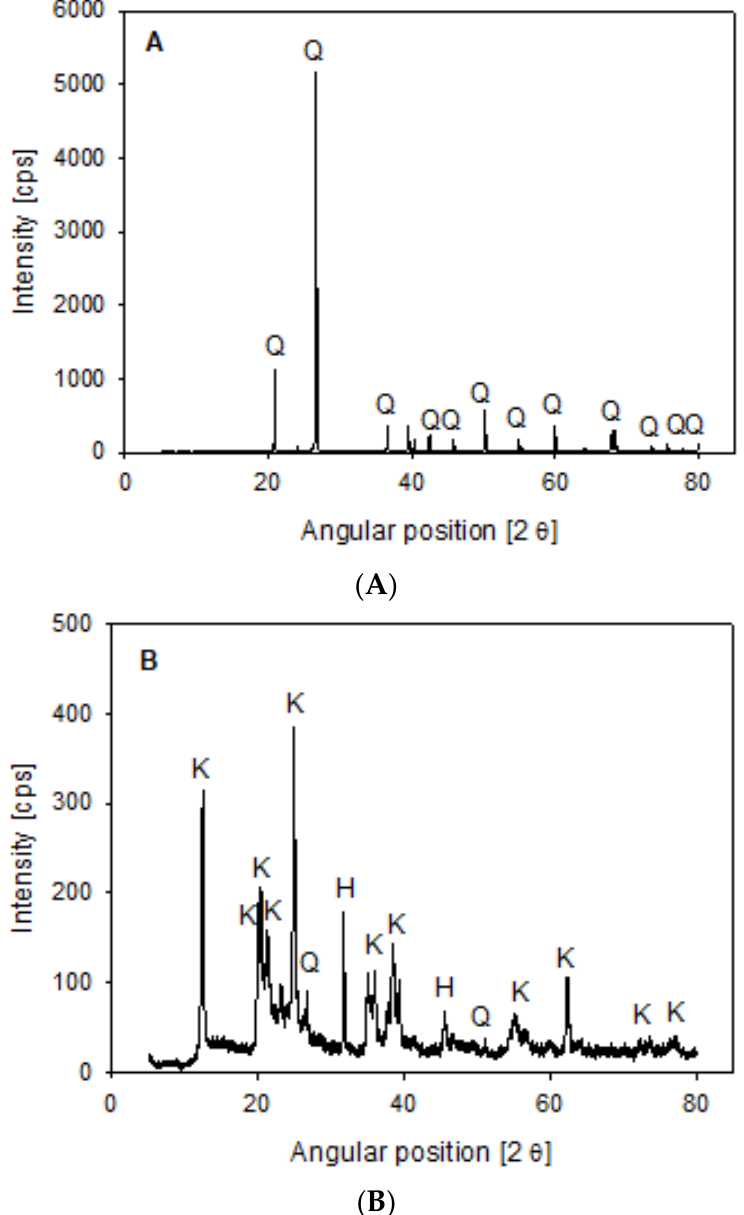
Figure 1. X-ray diffraction of quartz ( A ) and kaolin ( B ) powder, showing kaolinite (K), halite (H), and quartz (Q).